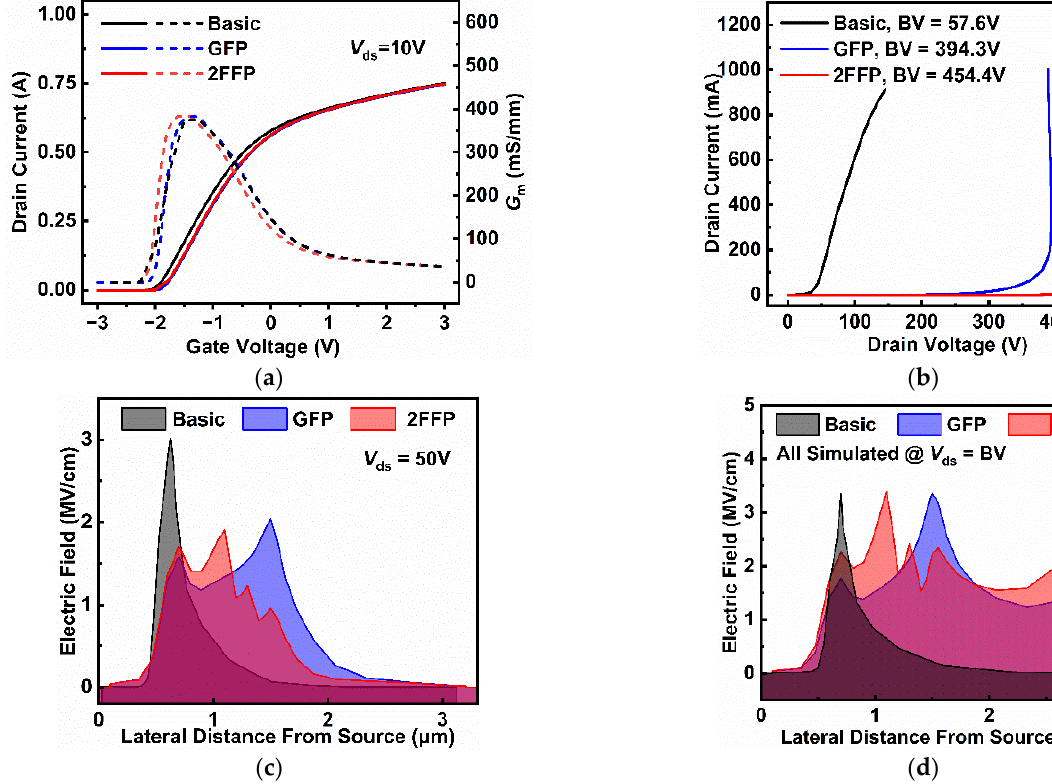
Figure 3. ( a ) Transfer characteristics and G m curves, ( b ) OFF-state breakdown characteristics, ( c ) elec- tric field distribution at V ds = 50 V, and ( d ) electric field distribution in the OFF-state and V ds = BV condition along the channel of the basic, GFP, and 2FFP HEMTs.